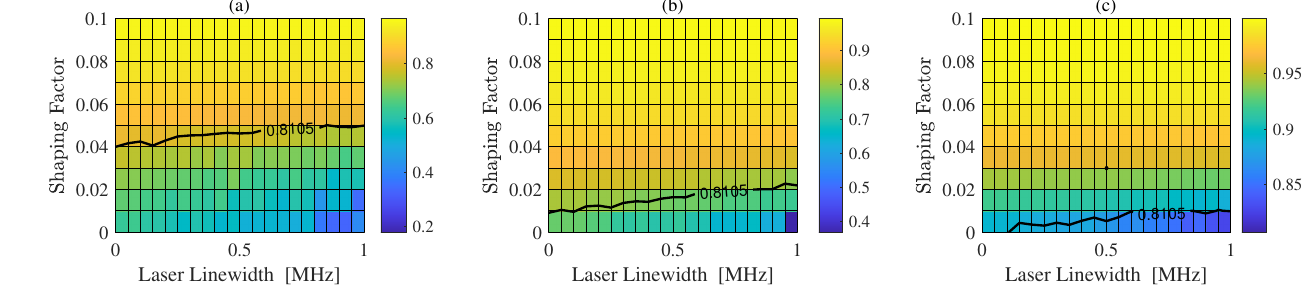
Figure 5. NGMI results as a function of SF and laser linewidth at symbol rate 32 GBd, with ( a ) SNR = 14, ( b ) SNR = 16, ( c ) SNR = 18. The black lines show the NGMI